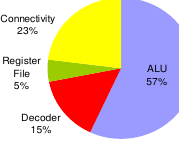
Figure 10. Percentage of processor logic elements (LE) per module.